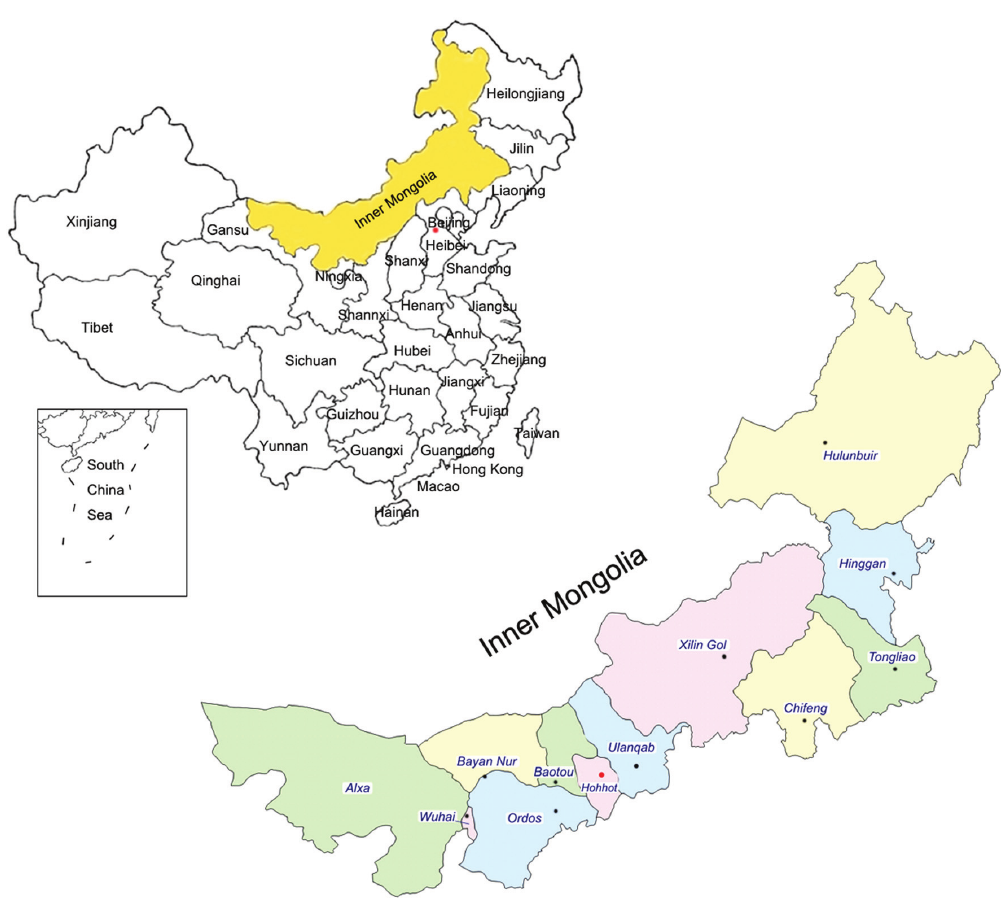
Figure 1 - Map of China (upper portion) and Inner Mongolia (lower portion), showing the area from where patients were